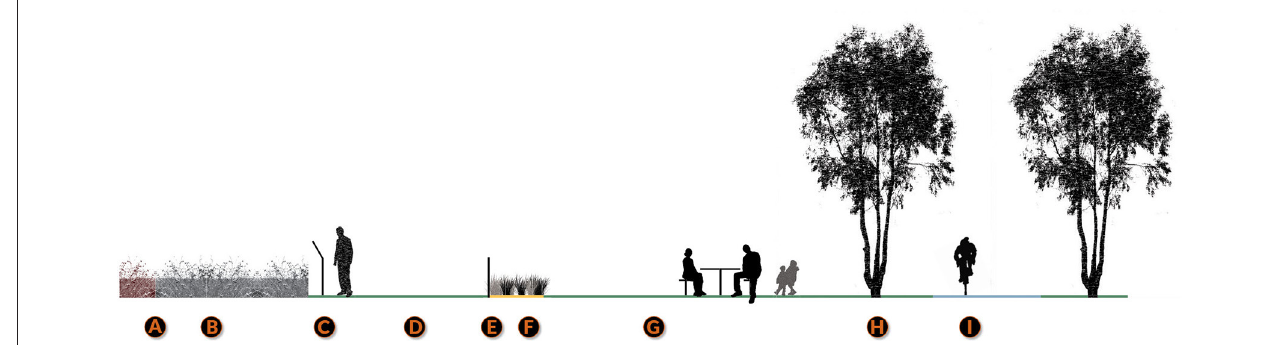
FIGURE 3 | Speaking users’ language. An idealized grassland, showing elements to be considered in design, is presented as a section and in a style that is familiar and reassuring to landscape architects, urban designers and planners. (A) Grassland. (B) Buffer planting of the grassland’s dominant tussock serves to prevent weed invasion. (C) Signage: High quality, fireproof, informative, part of a suite of educational signs located at entry points. (D) Firebreak: Mineral earth firebreaks should be avoided. If a grassland is adjacent to a road, then a firebreak is unnecessary, (E) Fencing.: Welcoming, low, fireproof, good quality, well-detailed, allowing easy entry. (F) Decorative plantings: Indigenous species chosen for visual appeal, ease of maintenance, and dense enough to suppress weeds. Mulch should be low-nutrient material such as gravel to avoid adding nutrients to the grassland. (G) Public open space: Generous provisionof public open space reduces pressure on adjacent grassland. Grading should serve to maintain existing hydrology. Turf should be native if possible, and secondary grassland (i.e., grassland not officially “conserved” in the grassland itself) should be set aside and used as the basis for the public open space. Turf should be maintained only with minimal herbicide use. (H) Trees: All trees should be well back to avoid shading grassland. (I) Shared trail: Connectivity, and encouraging engagement, are important. Shared trails can be designed to accommodate maintenance vehicles. Image: Adrian Marshall CC